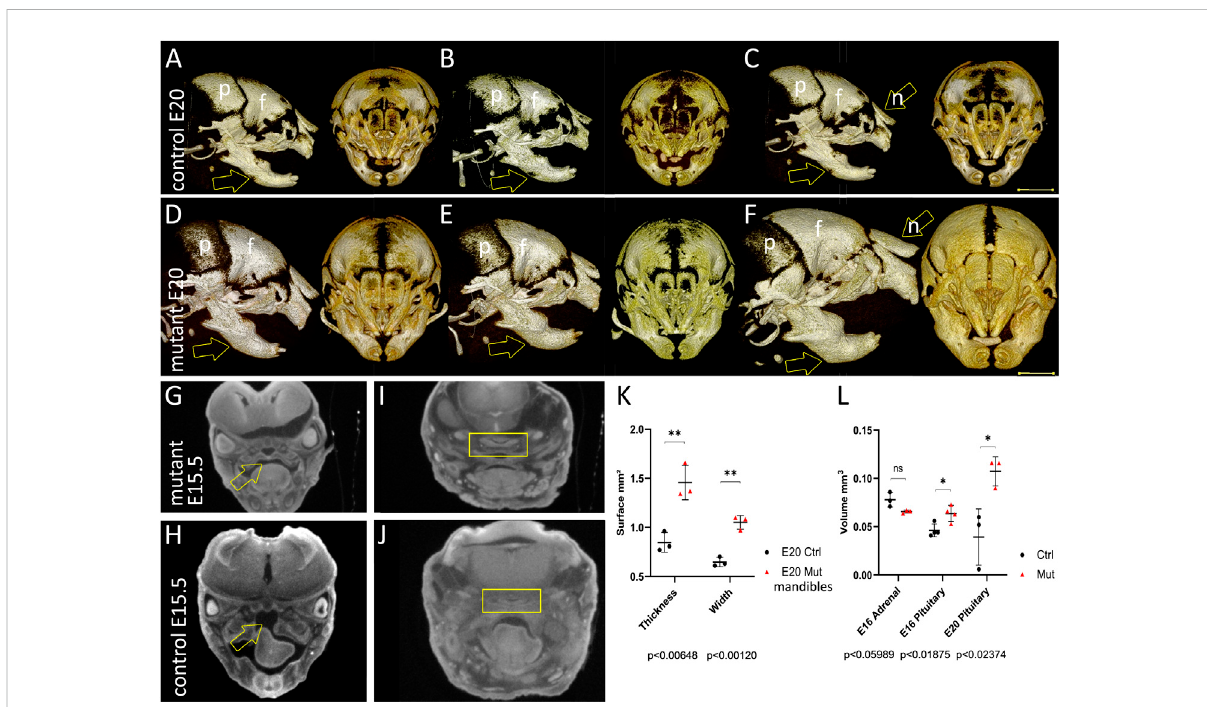
Micro-computed tomography (micro-CT) of skull development in Wnt1-Cre +/ ° ; Pik3ca H1047R/+ mice at late fetal stages. (A – C) 3D projections in frontal and sagittal views of the more advancedmineralization of three representative skulls of control littermatefetusesat E20.5 relativeto mutants in (D – F) , within neural crest-derived craniofacial bones. Arrows indicate point of measurements of mandibular bone thickness in (K). (G) Control littermate fetus at E15.5 relative to mutant in (H) – frontal micro-CT section through eyes, brain, palate (arrow), tongue and jaw. (H) Mutant littermate embryo of E15.5 embryo in (G) – frontal micro-CT section through eyes, brain, cleft palate with malpositioned tongue (arrow) and jaw. (I,J) Frontal sections through the pituitary gland (yellow rectangle) in a control (I) or Wnt1-Cre +/ ° ; Pik3ca H1047R/+ fetus at E15.5 (J). (K) Measurements from theramusbasetojustanteriortothemolaralveolus,inbothrostrocaudalthickness(height)andmediolateral width,showsigni fi cantenlargementof mutant mandibles by birth. (L) Segmentation analysis of the volumes of the adrenal and pituitary glands at E16 and the pituitary at E20, showing that unlike the adrenal gland, there is a signi fi cant increase in pituitary size at the end of gestation. f, frontal; n, nasal; p, parietal; ns, not signi fi cant; * p < 0.05; ** p <